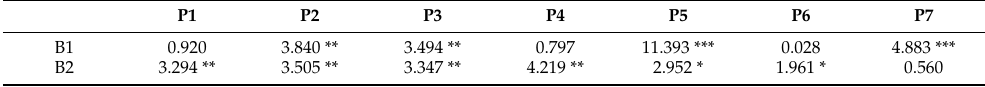
Table 10. Restorative effects differences of different stay time, MVPA time and park